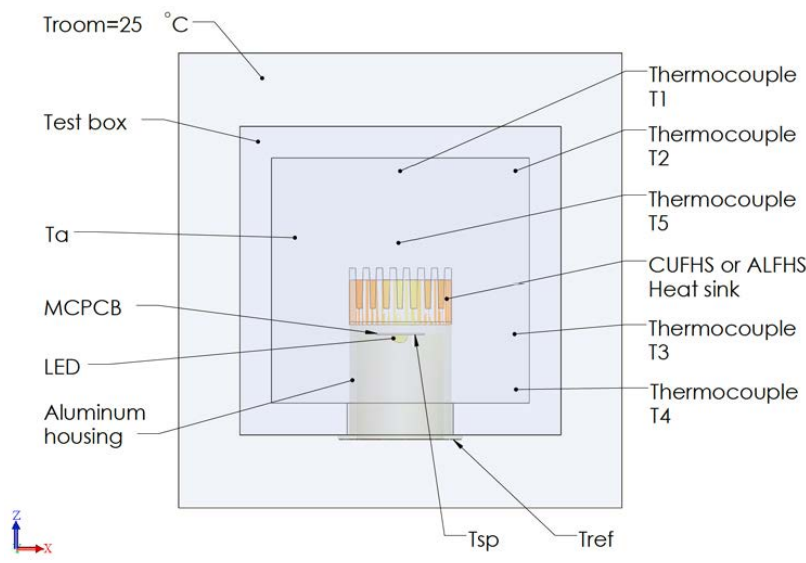
Figure 1. Illustration of the ALFHS or CUFHS mounted to the CLRDL after INST.